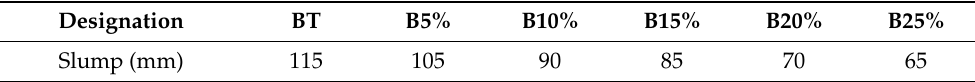
Table 5. Slump of fresh